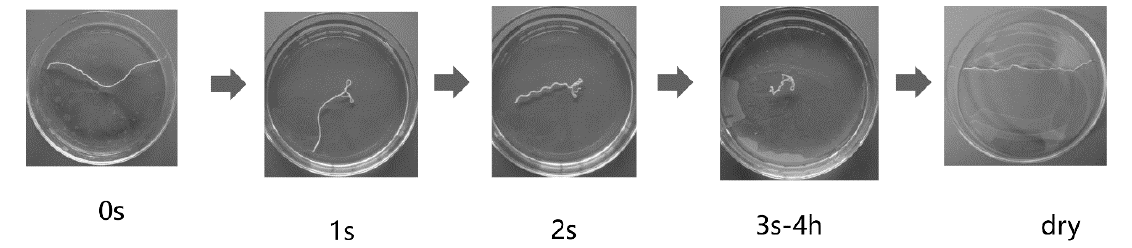
Figure 5. Images of sequential addition of water on hydrogel-coated wool yarns.